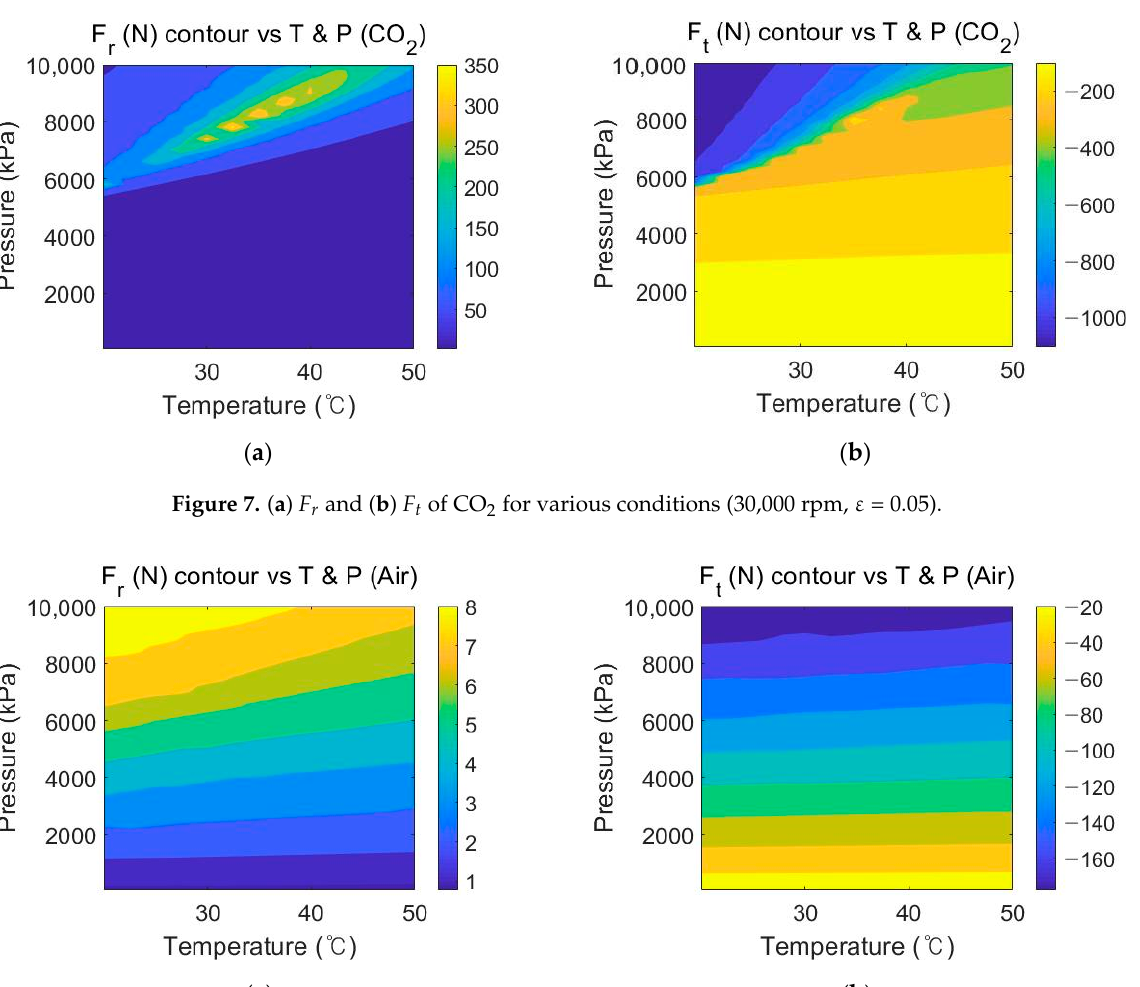
Figure 6. Pressure distribution around a rotating shaft: ( a ) 7.5 MPa, 30 °C CO 2 inlet and 30,000 rpm conditions with various eccentricity ratio. ( b ) description of fluid force exerted on the shaft caused by pressure distribution